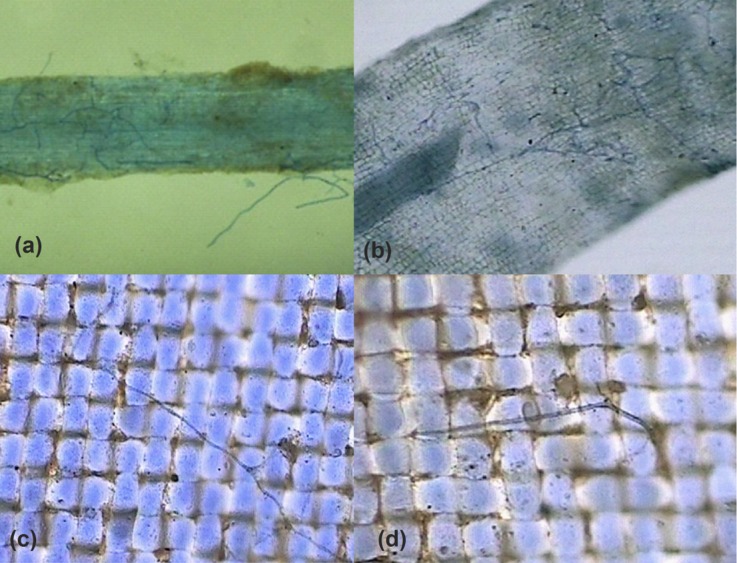
Root AM colonization of white clover (a) and trifoliate orange (b) and the AM hyphae (c and d) in 37 μm nylon-mesh.Meanwhile, a and b subfigure indicated that Diversispora spurca entered the root cell to form intraradical hyphae or extraradical hyphae, and c and d subfigure indicated that extraradical mycorrhizal mycelium went through 37-μm nylon-mesh from one compartment to another compartment.